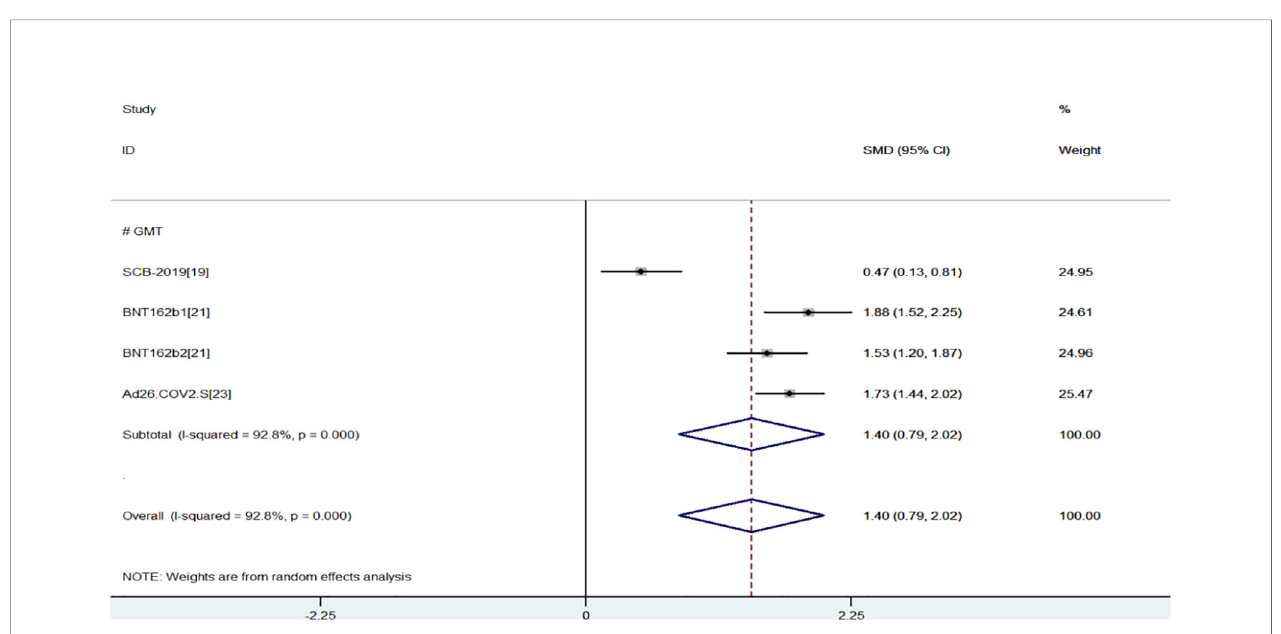
FIGURE 2 | Meta-analysis of GMT between the experimental group (young adults) vs control group (older